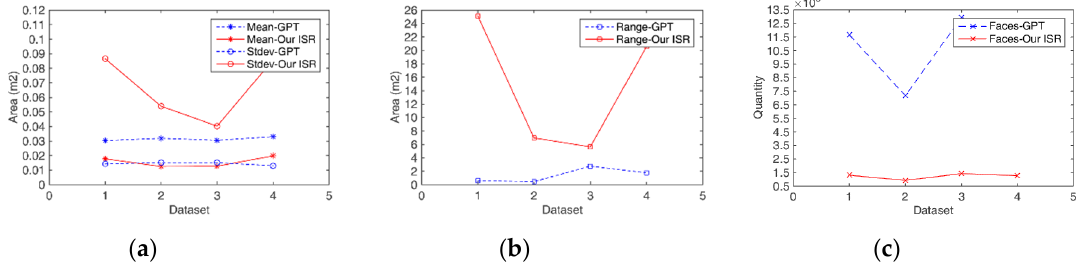
Figure 24. Statistics of patches in the mesh model: ( a ) Mean and Stdev , ( b ) Range , and ( c ) Quantity . The Mean and Stdev from greedy projection triangulation (GPT) were enlarged by 100 times for visual display effect.